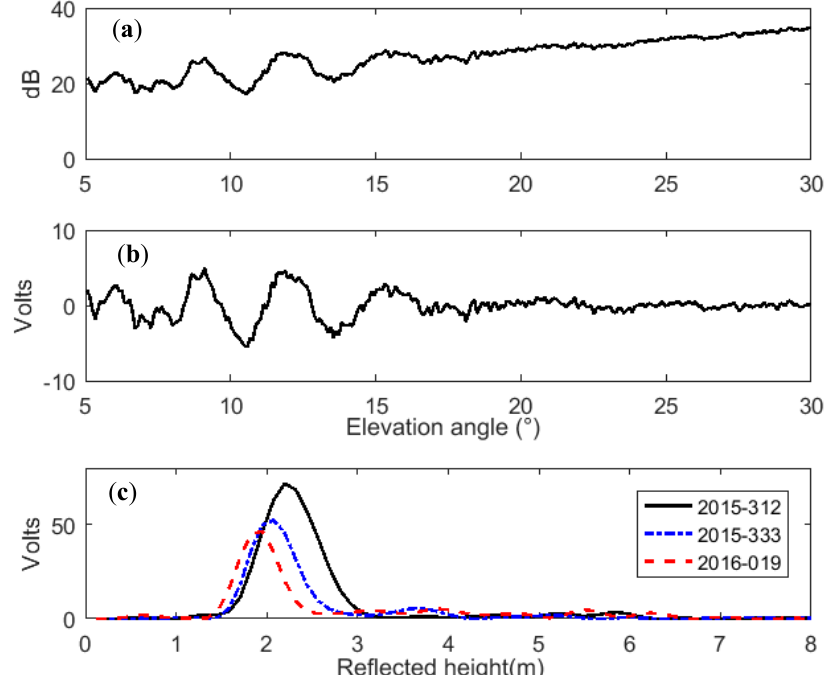
Figure 3. Recorded L2C signal-to-noise ratio (SNR) data for satellite PRN7 at p025. ( a ) Original L2C SNR data on day of year (DOY) 321, 2015; ( b ) detrended SNR data with the trend removed by a second-order polynomial; ( c ) reflected height from the detrended SNR data with the elevation angle ranging from 5° to 20° by Lomb–Scargle periodogram on DOY 2015-312, 2015-333, and 2016-019. The detrended SNR can be modeled with Equation (2). For a given parameter h , the detrended SNR curve should have a constant amplitude and frequency, which is a function of elevation angle e .